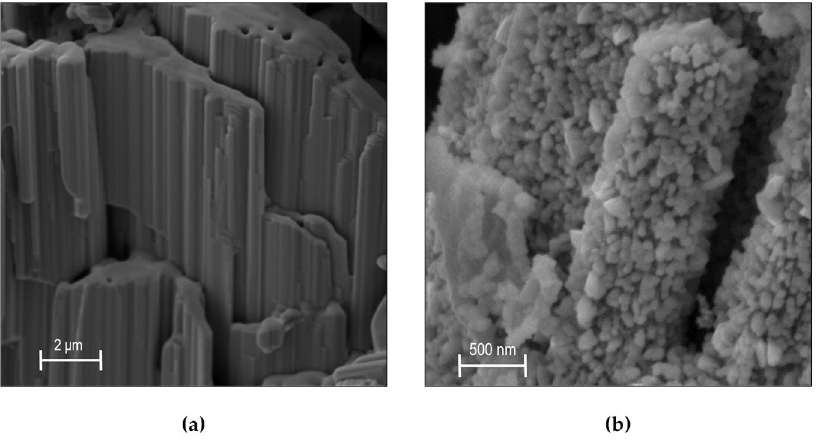
Figure 1. SEM images showing the columnar structure of the Nb 2 O 5 raw material ( a ) and the product after the solvothermal reaction using the Nb 2 O 5 without pre-milling ( b ).